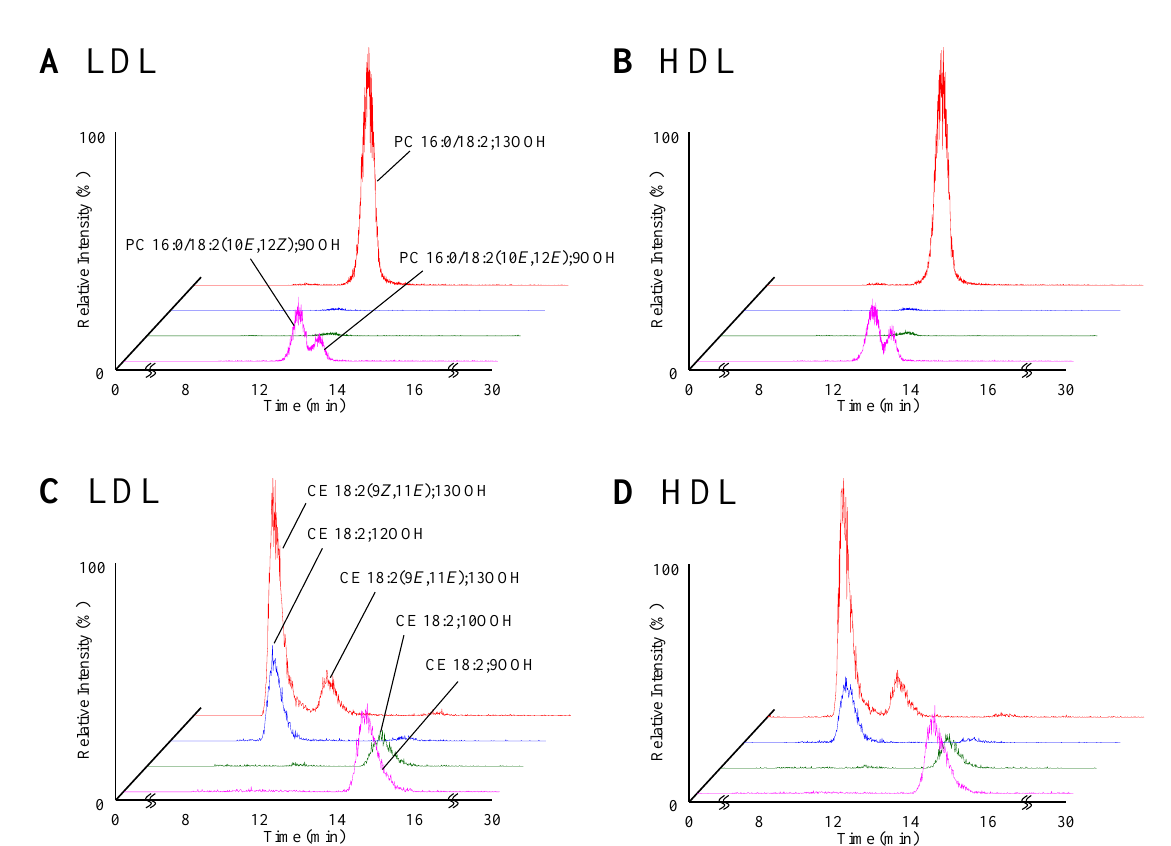
Figure 4. MRM chromatograms of PC 16:0/18:2;OOH isomers ( A , B ) and CE 18:2;OOH isomers ( C , D ). LOOH extracted from LDL ( A , C ) and HDL ( B , D ) were analyzed.